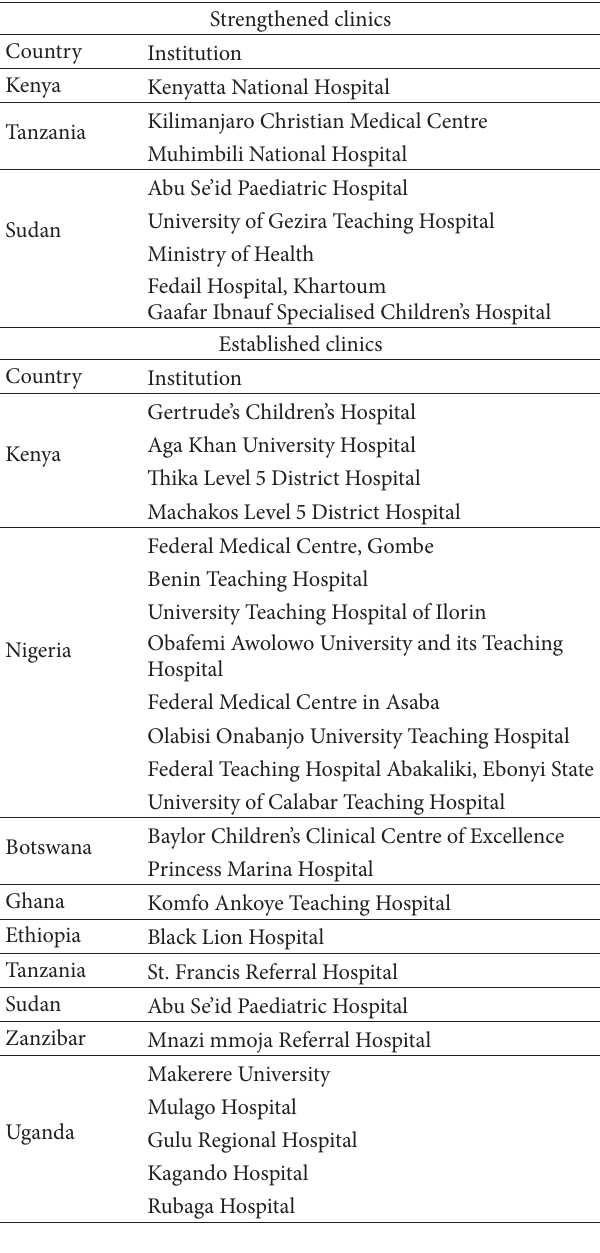
Table 3: Clinics strengthened and established by graduates of the PETCA